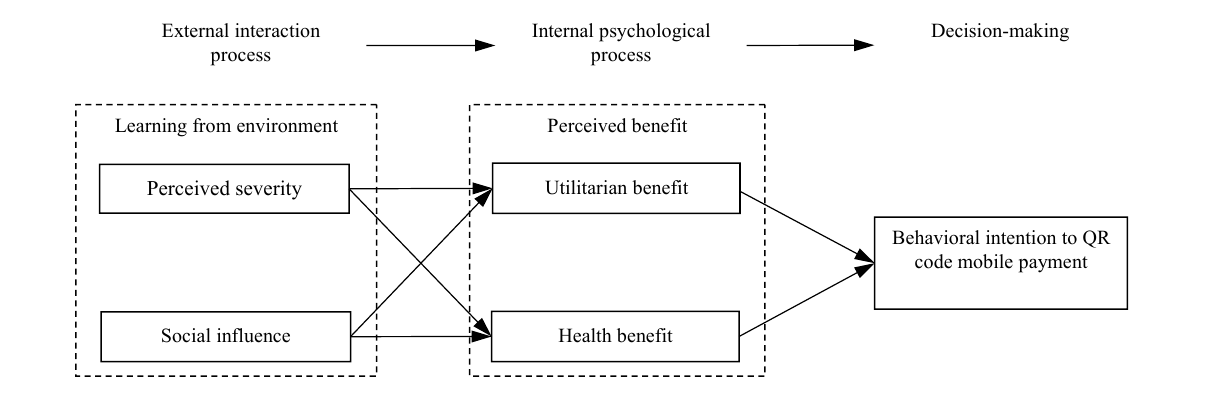
FIGURE 1 | Research